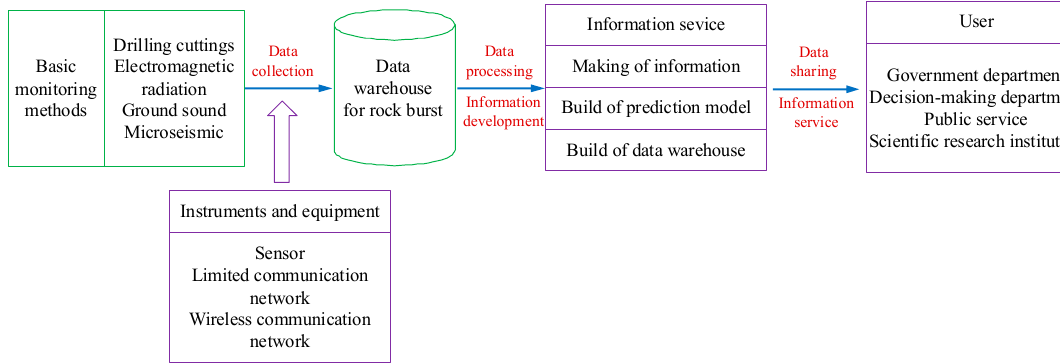
Figure 1. Overview structure of the intelligent early warning system for rock bursts (IEWSRB).